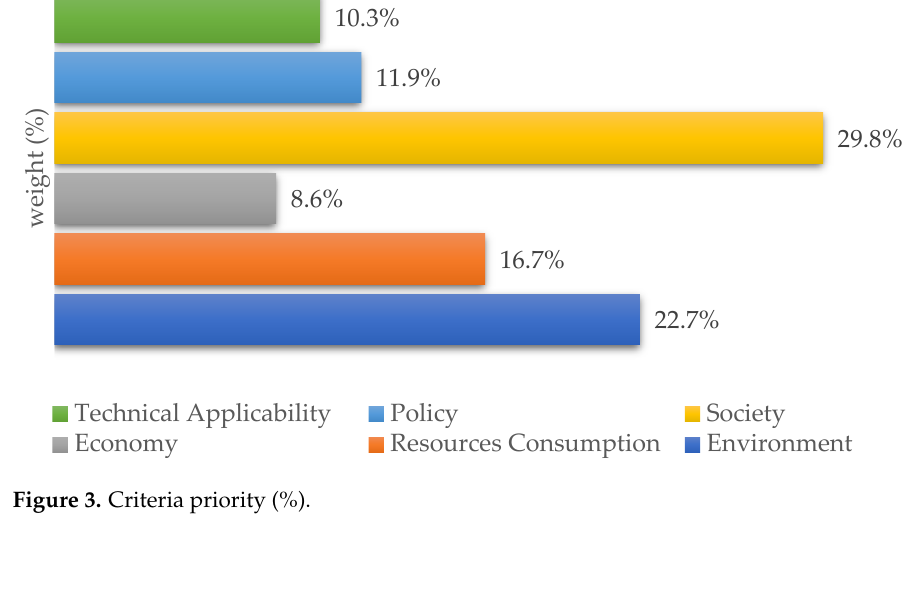
Figure 3. Criteria priority (%).